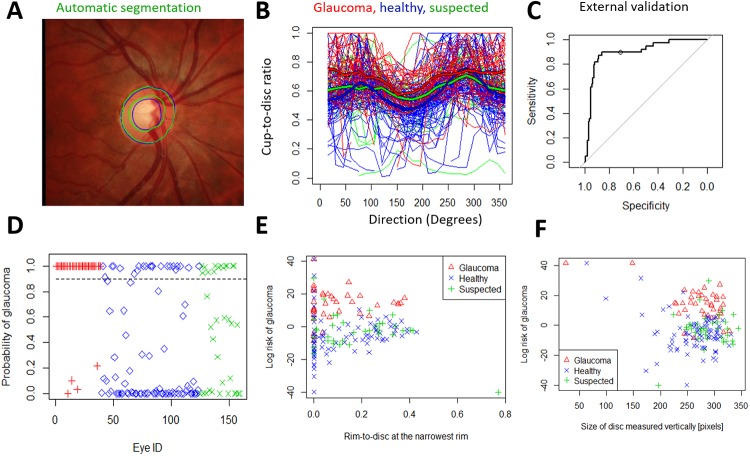
External validation of the spatial detection algorithm using the automatically segmented images from RIM-ONE.Here, all ORIGA-light images were used to train the segmentation and the glaucoma detection. The RIM-ONE images were then automatically segmented and glaucoma detection was tested. A) The grader's semi-automatic segmentation (blue) and the fully automatic segmentation (green). B) The individual automatically segmented profiles of 39 glaucomatous, 85 healthy and 35 suspected optic discs. C) The AUROC in external validation was 91.0% for discrimination between glaucomatous and healthy. The threshold probability of 0.90 (see the circle) yields 89.7% sensitivity and 74.1% specificity. D) The posterior probability of glaucoma in the three RIM-ONE groups with the 0.90 threshold (dashed line). The algorithm identified as glaucomatous: 35 out of 39 glaucomatous (90%), 22 out of 85 healthy (26%), and 13 out of 35 suspected (37%) eyes. E) The risk of glaucoma (log(p/(1-p)) vs Rim-to-Disc ratio at the narrowest rim. F) The risk of glaucoma vs disc size.